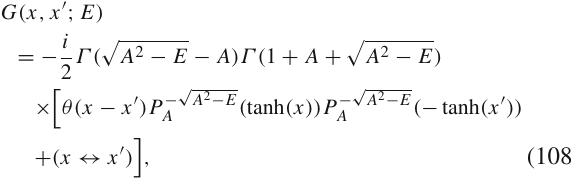
Fig. 5 Quantum-mechanicalpotentials U + (dashedline)and U − (solid line) of the extended (sG + E) model for a 2 = b 3 = 0, and α =